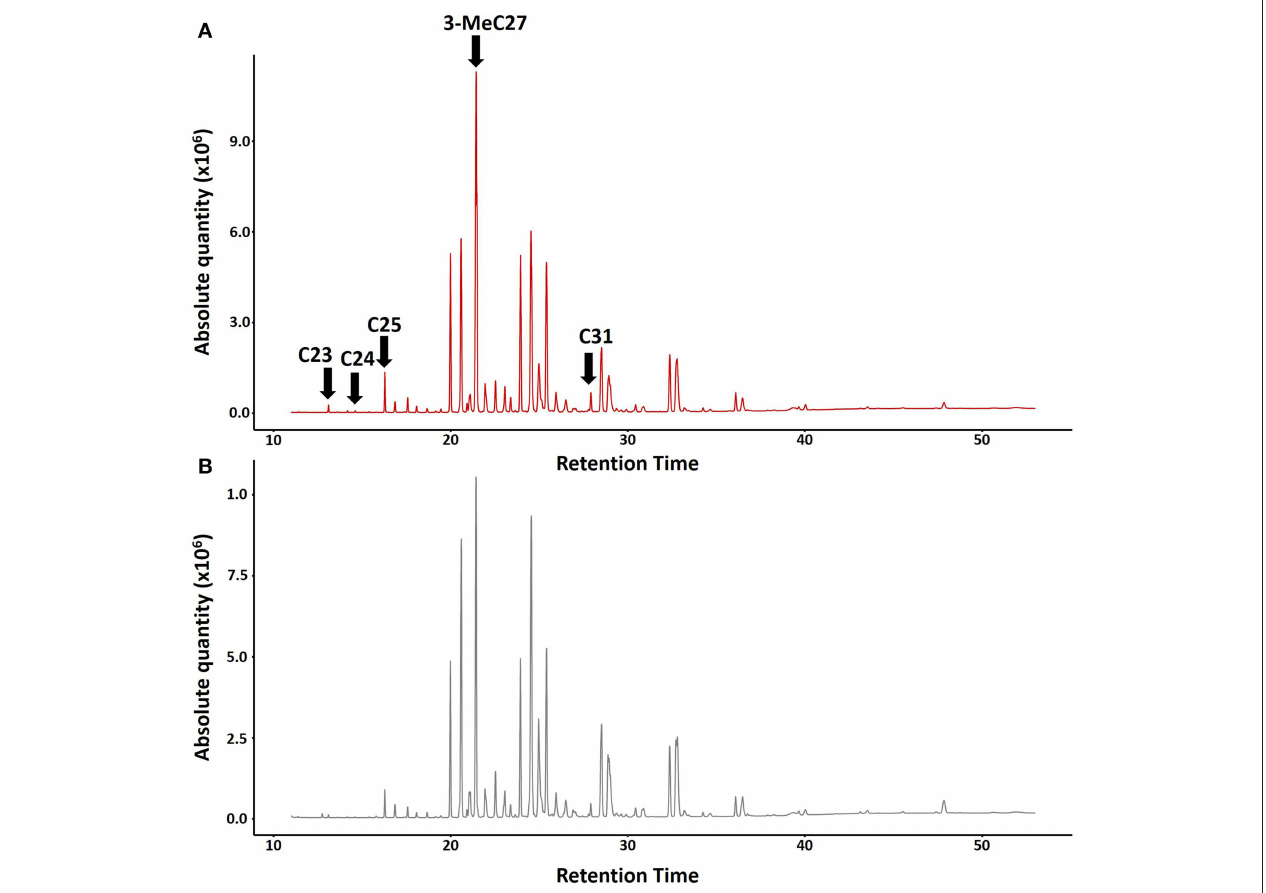
FIGURE 1 | Typical chromatograms showing absolute quantities of CHCs in Polistes satan (A) Dominant queen (top, red) and (B) Subordinate female workers (bottom, gray). Arrows indicate the compounds tested in our bioassays: n -C 23 , n -C 24 , n -C 25 , 3-MeC 27 , and n -C 31 .